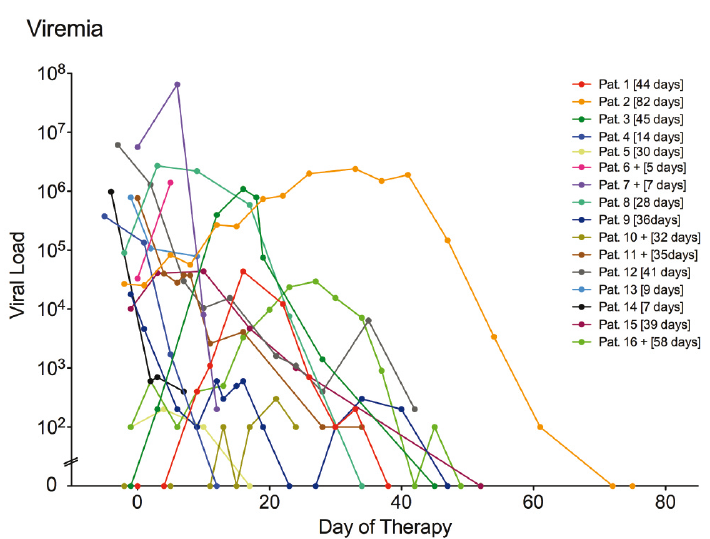
Figure 1. Kinetics of Adenovirus blood viral load under cidofovir treatment. Viral loads of 16 patients with quantitative blood adenovirus PCR treated with cidofovir, are shown. Day of therapy ≤ 0 denotes pre-treatment viral loads. Up to two post-treatment values are shown where available and informative. Each patient’s individual treatment duration is shown in the legend. + denotes patient